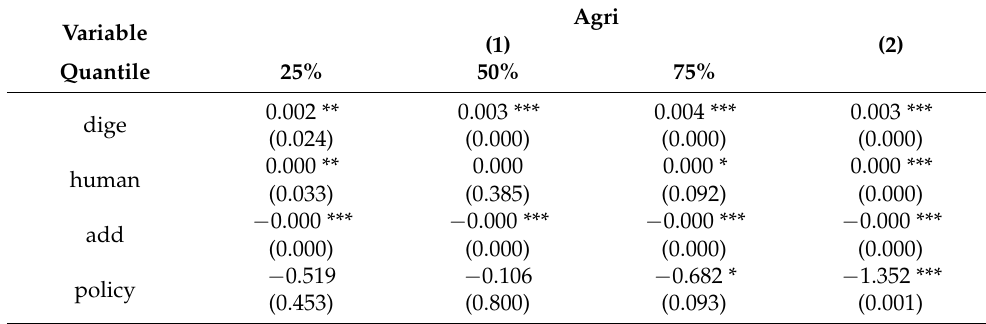
Table 9. Robustness test